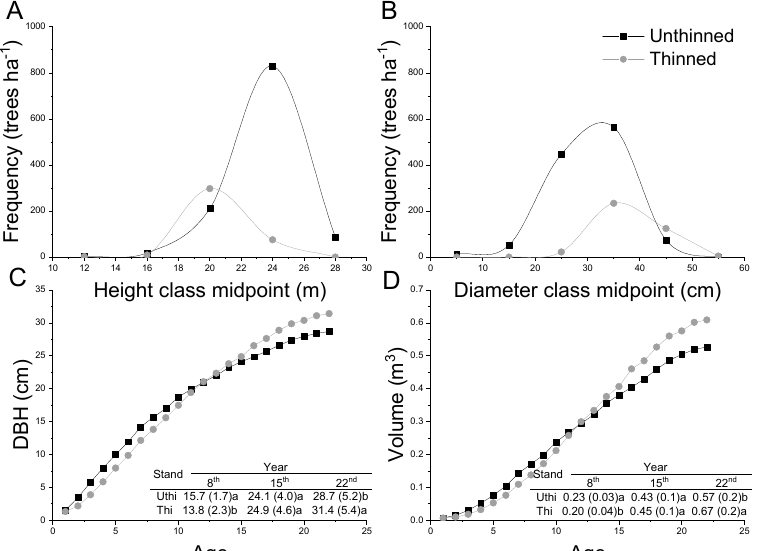
Figure 2. ( A ) Stem diameter, ( B ) height frequency, ( C ) DBH, and ( D ) wood volume of 22-year-old P. patula . The lower right corner shows the DBH and volume pairwise comparison (Tukey test) in different years. Different letters (a, b) indicate statistically significant differences between the thinned and unthinned plots in years 8, 15, and 22 ( p < 0.05).